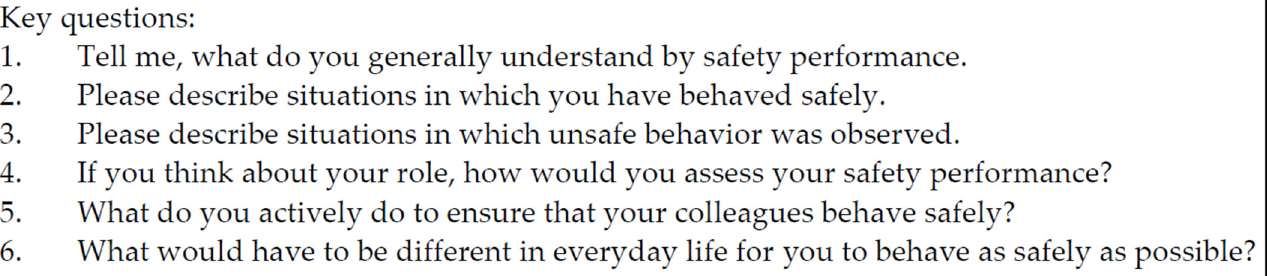
Figure 1. Key questions of the semi-structured interviews.